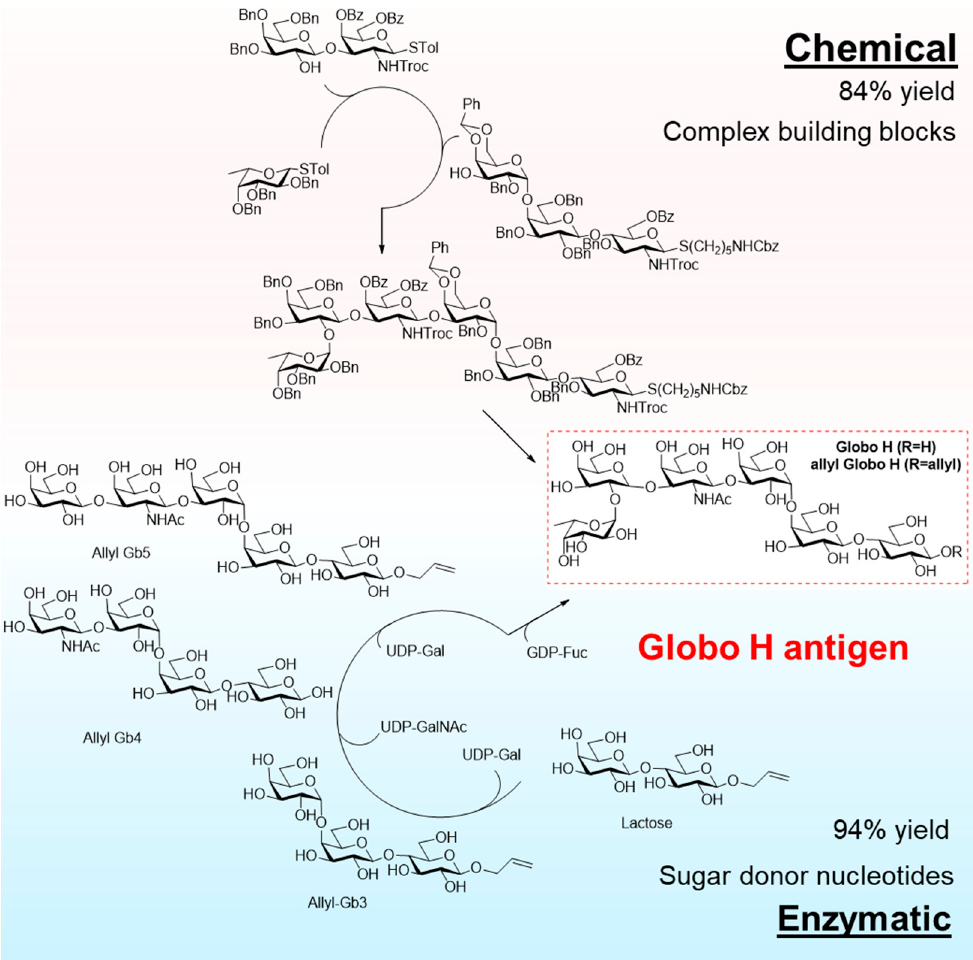
Figure 11. Reaction scheme of both the multistep chemical glycosylation utilizing previously synthesized carbohydrate building blocks [221] and enzymatic glycosylation utilizing nucleotide sugar donors for linear saccharide elongation capped with a terminal vinyl group [129]. The top half of the figure was adapted from [221], copyright 2006, National Academy of Sciences.